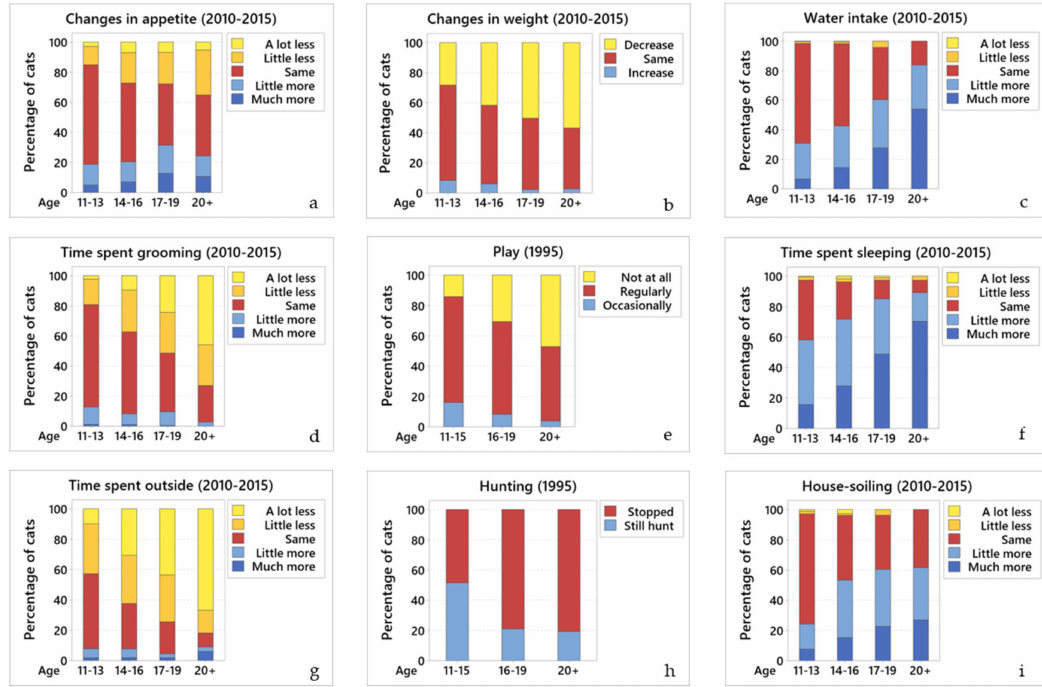
Figure 2. Changes in the di ff erent behaviours across age groups. Comparative graphs showing changes in behaviour across age groups for ( a ) changes in appetite (2010–2015); ( b ) changes in weight (2010–2015); ( c ) water intake (2010–2015); ( d ) grooming (2010–2015); ( e ) play behaviour (1995); ( f ) amount of time sleeping (2010–2015); ( g ) outside access (2010–2015); ( h ) hunting behaviour (1995); and ( i ) house-soiling (2010–2015). In all graphs of this panel, blue colours represent an increase in the particular behaviour, yellow represent a decrease, and red represent no